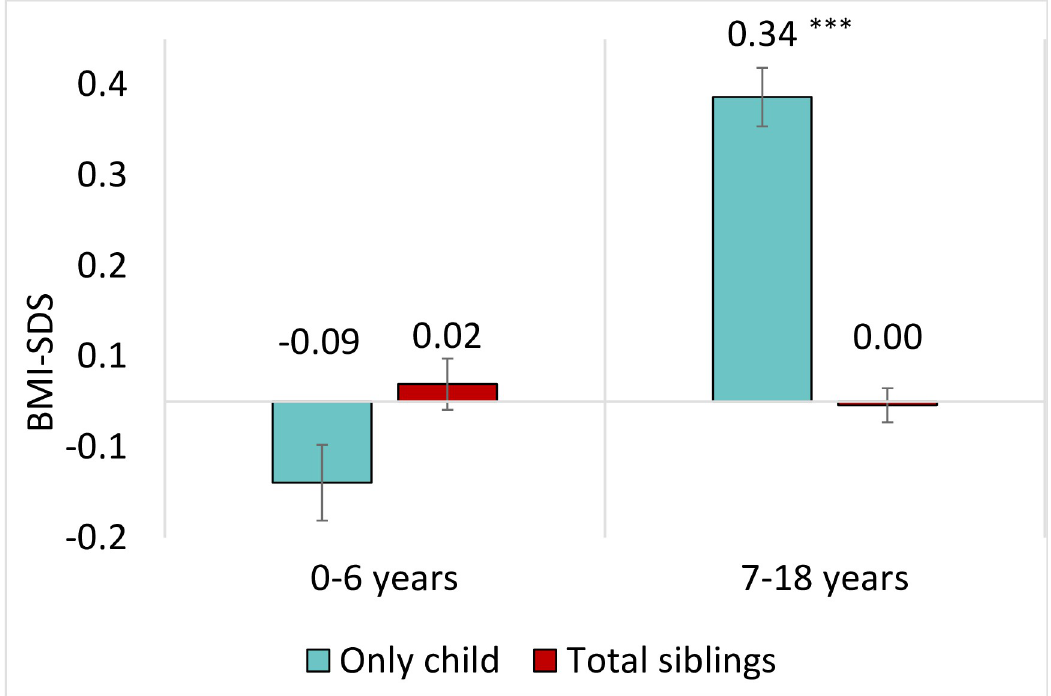
Fig 1. BMI-SDS by age range and sibling status. In each age range, the statistical reference group was “total siblings”. Significant differences between only children and children with siblings are presented as means with a vertical error indicator (standard error of the mean): ��� p < 0.001. Abbreviations: SDS, standard deviation